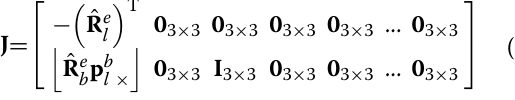
Multi‑GNSS PPP measurement model